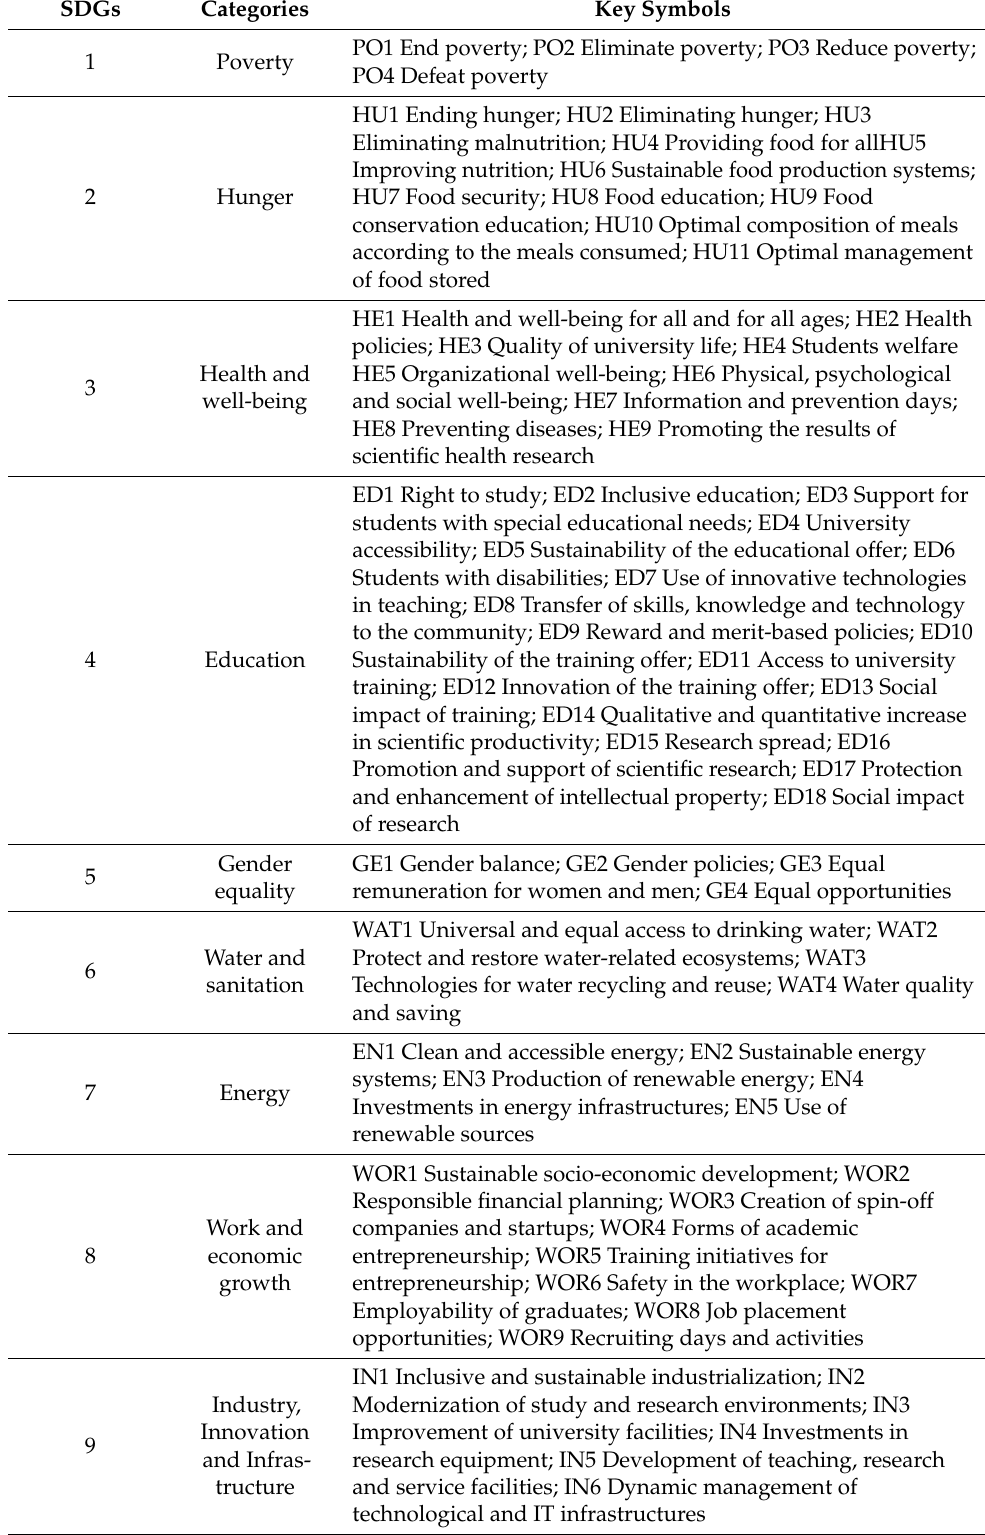
Table 2. The coding instrument for SR in Universities. Source: Author’s